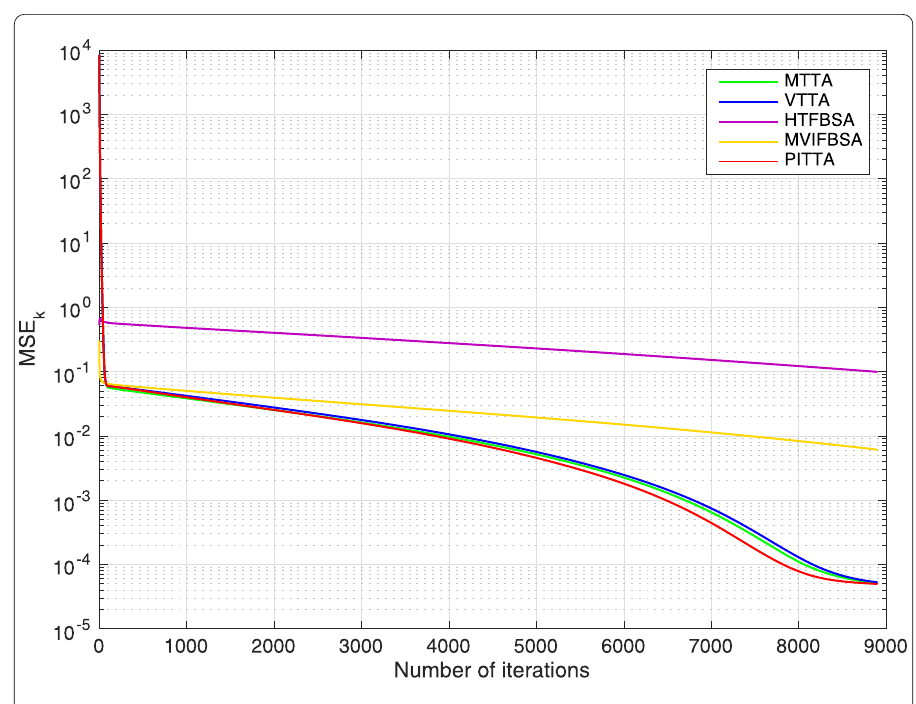
Figure 2 The mean-squared error versus the number of iterations for m = 100